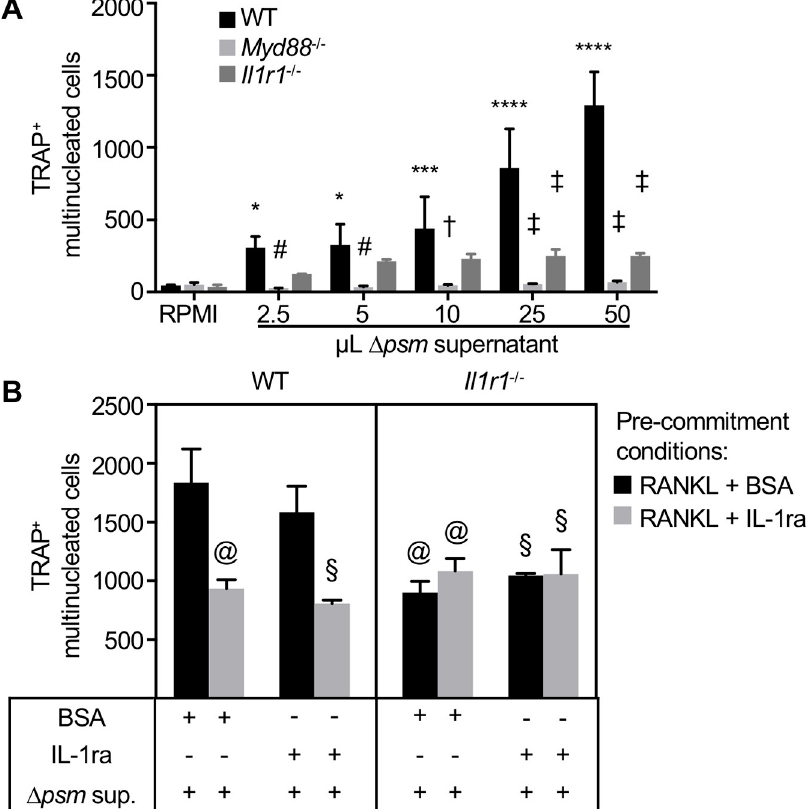
Fig 8. MyD88 and IL-1R signaling drive S. aureus enhancement of osteoclast differentiation in vitro . (A) Osteoclast precursors were generated from primary WT, Myd88 -/- , and Il1r1 -/- BMMs by treatment with 35 ng/mL RANKL treatment for 48 hours. After washing 2X with PBS, fresh media was replenished, and cells were stimulated with vehicle (1% casamino acid-supplemented RPMI) or toxin-deficient S. aureus supernatant ( Δ psm ) in the absence of ongoing RANKL treatment. All cells were TRAP stained in vitro at day 6 and TRAP + multinucleated cells were manually quantified using OsteoMeasure software ( n = 3 wells per condition, representative of duplicate experiments). (B) WT and Il1r1 -/- enriched BMMs were stimulated with 35 ng/mL exogenous RANKL for 2 days before stimulating with Δ psm supernatants for four days. In order to determine the contribution of IL-1 signaling in this assay, vehicle (0.1% low endotoxin BSA) or recombinant murine IL-1ra (1 μ g/mL) were added during the 2 days of RANKL pre- commitment (BSA, black bars; IL-1ra, grey bars) or during the 4 days of Δ psm supernatant stimulation (indicated by + under each bar). The top line of each bar represents the mean and error bars represent standard deviation. A repeated measures two-way ANOVA with Dunnett’s multiple comparisons test was performed on cell counts from each genotype, comparing each dose of Δ psm supernatant to the vehicle control, where � p < 0.05, ��� p < 0.001, ���� p < 0.0001, and if not designated by asterisks is non-significant. A repeated measures two-way ANOVA with Tukey’s multiple comparisons test was performed to compare Myd88 -/- and Il1r1 -/- TRAP + multinucleated cell counts to WT counts within each Δ psm supernatant dose, where # p < 0.05, † p < 0.001, and ‡ p < 0.0001. A three-way ANOVA with Tukey’s multiple comparisons test compared the effects of genotype, IL-1ra treatment during RANKL pre-commitment, and IL-1ra treatment during Δ psm supernatant stimulation. Statistical comparisons to WT cells pre- committed with RANKL + BSA and Δ psm supernatant + BSA (first black bar from the left) are reported as @ p < 0.05, or compared to WT cells pre-committed with RANKL + BSA and Δ psm supernatant + IL-1ra (second black bar from the left) are reported as § p < 0.05. Comparisons between all RANKL + IL-1ra pre-commitment conditions (grey bars) were